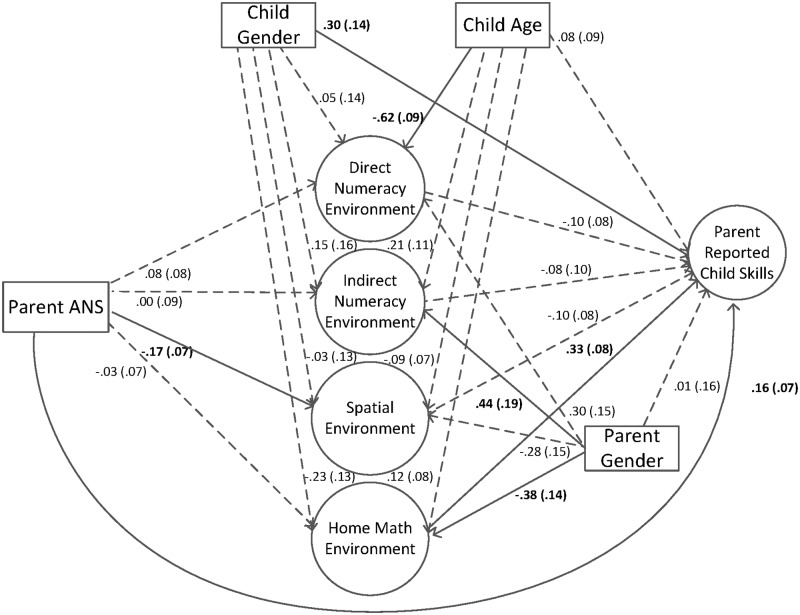
Home math environment factors and parent ANS predicting parent report of child skills.Standard errors are in parentheses. Solid lines and bolded text represent significant pathways, p < .05. Longdash lines represent non-significant pathways, p > .05.